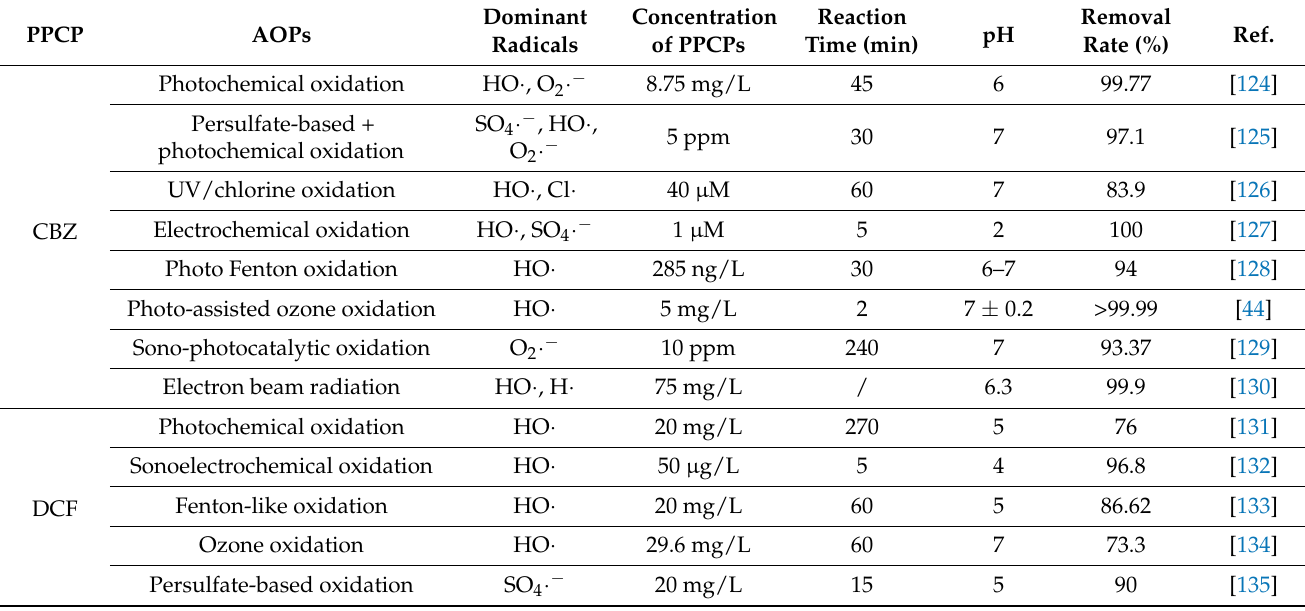
Table 2. Degradation compilation of frequently detected PPCPs via various AOPs.